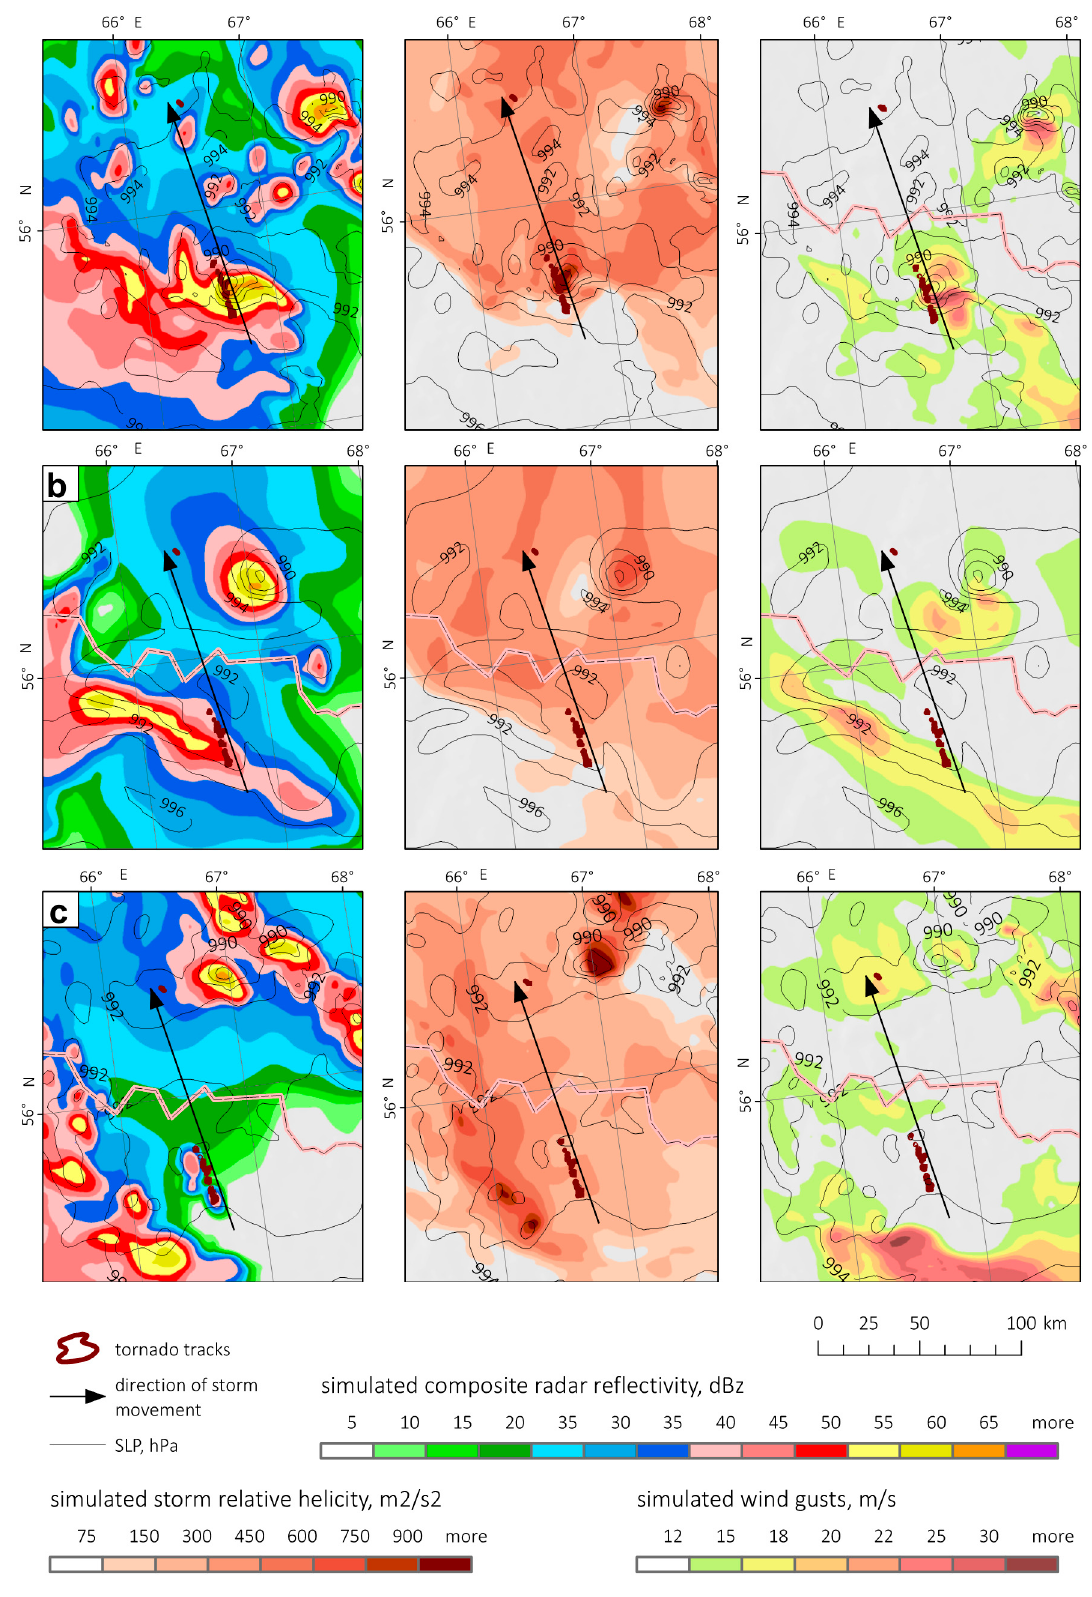
Figure 10. WRF-simulated composite reflectivity (dBz), storm-relative helicity (m 2 s − 2 ), and wind gusts (m s − 1 ) at 1300 UTC 18 June 2017 with various model grid resolution settings: 3 km with no nested grid ( a ), 7.2 km with no nested grid ( b ), and 9 km with 3-km nested grid ( c ).